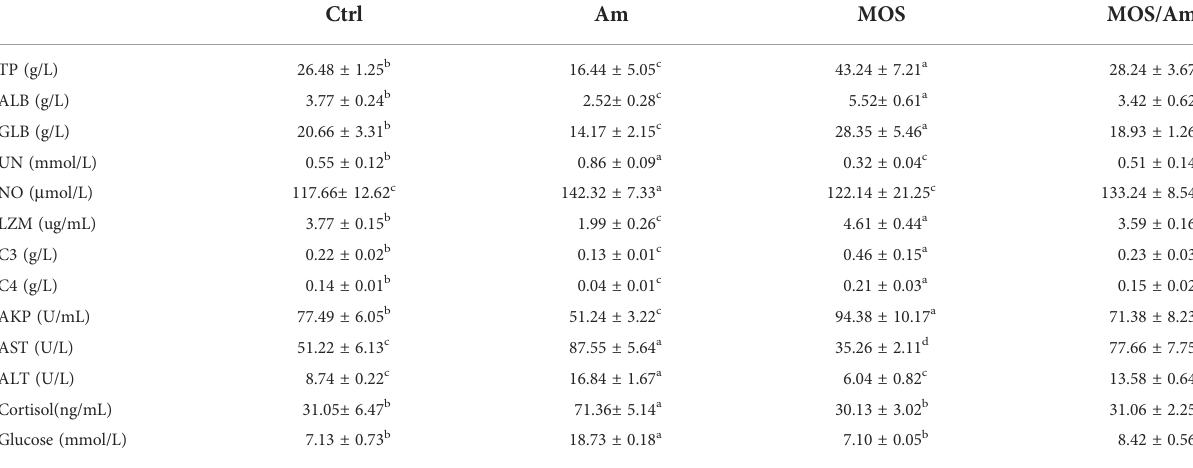
TABLE 5 Effects of dietary MOS on the serum biochemical and immune parameters of the common carp under ammonia stress for 30